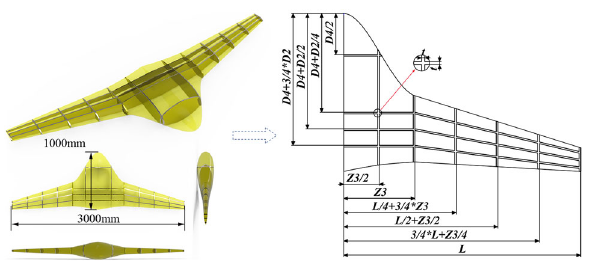
Fig. 17 Structure parameters diagram and illustration of BWBUG